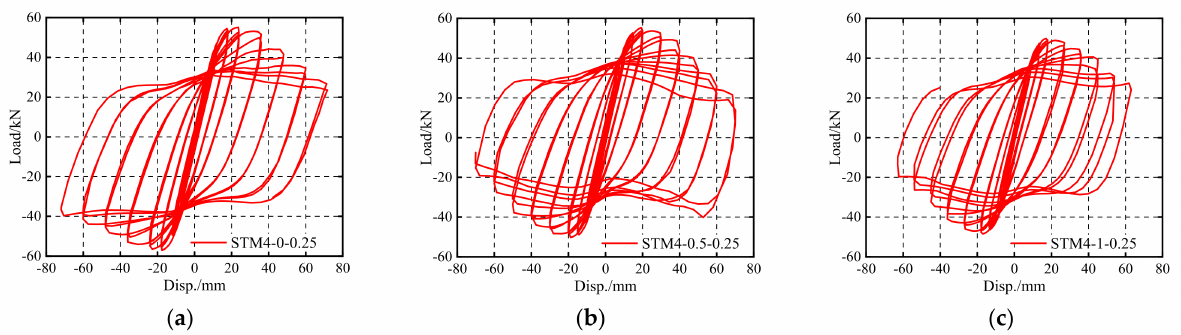
Figure 9. ( a ) Hysteresis curves for RBACFST columns of STM4-0-0.25; ( b ) hysteresis curves for RBACFST columns of STM4-0.5-0.25; ( c ) hysteresis curves for RBACFST columns of